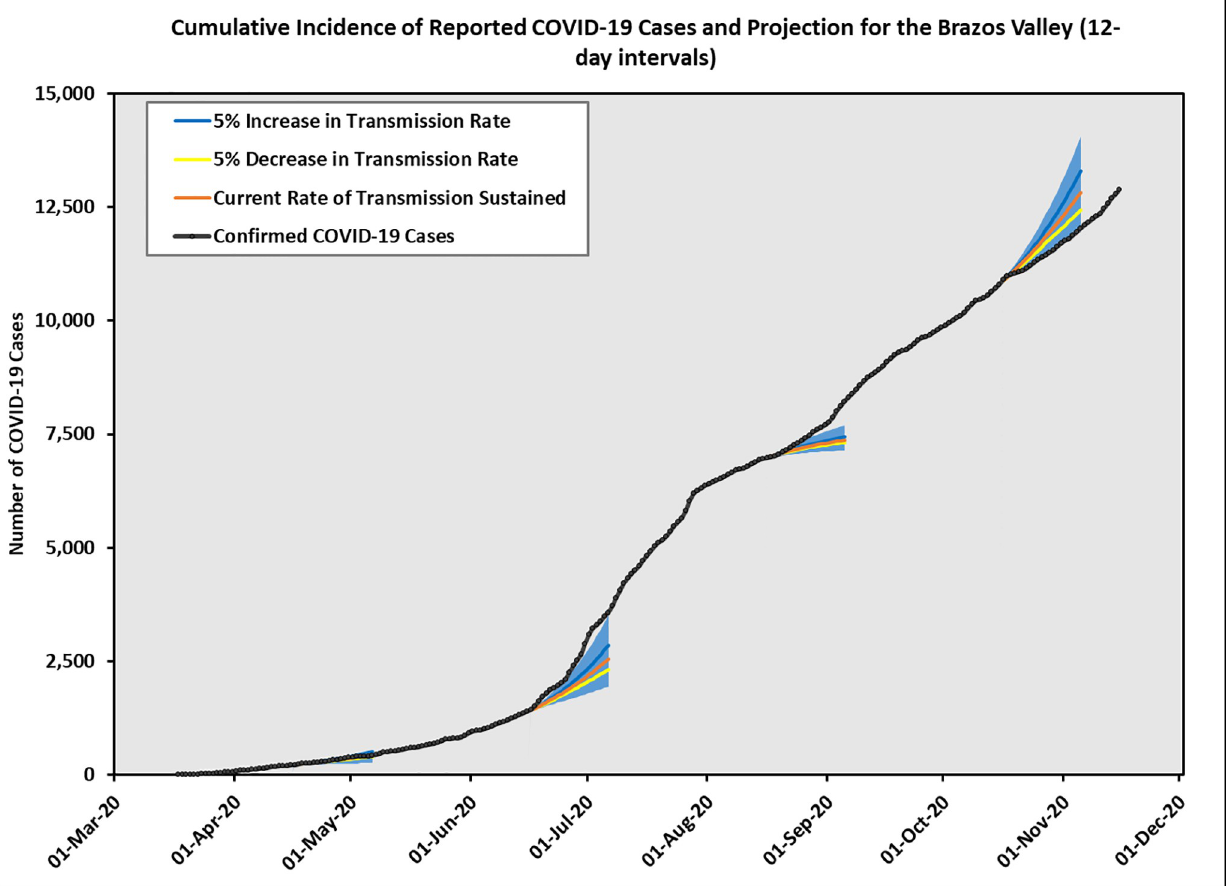
Fig 6. Brazos Valley predicted cumulative incidence cases using 12-day intervals. Three solid lines represent the predicted cases corresponding to current rate of transmission sustained, 5% increase in transmission rate, and 5% decrease in transmission rate. The shaded areas indicate prediction